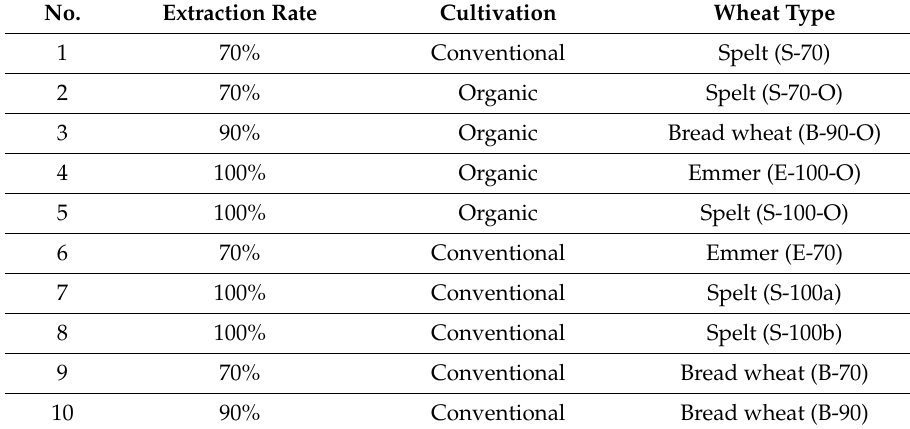
Table 1. Studied Triticum flours with their extraction rates, type of cultivation, and type of wheat.